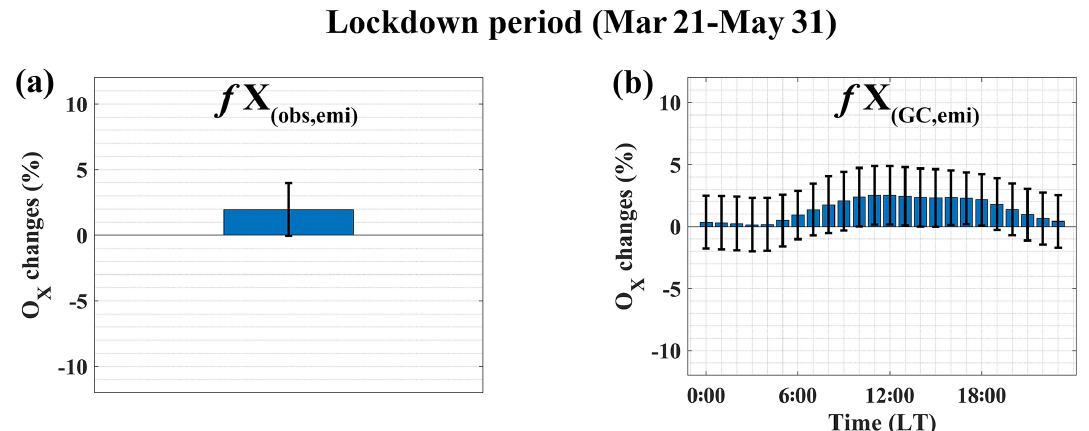
Figure C1. Mean changes in in situ O x with meteorology accounted for between 2020 and 2019 (a) . Diurnal cycle of GC O x concentra- tion changes with emissions accounted for between 2020 lockdown and 2020 BAU (no lockdown) scenarios ( f X (GC , emi) ) (b) . Error bars represent the 1 σ of the mean of 10 metropolitan